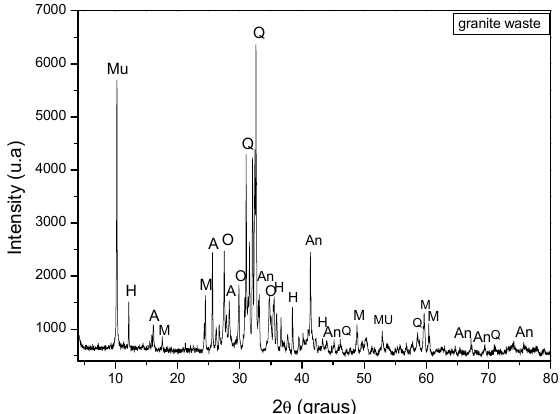
Figure 4. X-ray diffractogram of the multiwire gangsaw waste. A = Albite, An = Anortite, H = Hornblende, Mi = Microcline, Mu = Muscovite, O = Orthoclase, Q = Quartz.